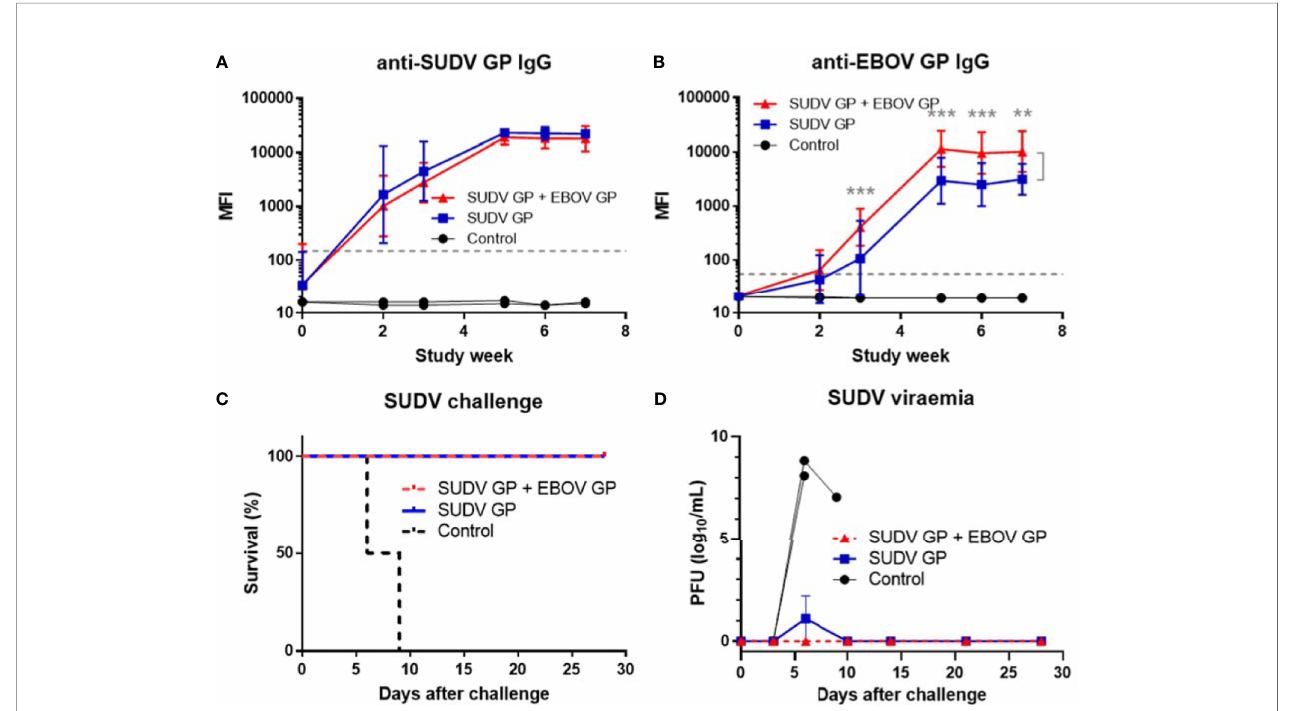
FIGURE 4 | Immune response after SUDV vaccination, survival and viremia after SUDV challenge. MIA performed in triplicate for animals vaccinated at three-week intervals with three doses of SUDV GP with adjuvant (n=4) or SUDV GP + EBOV GP with adjuvant (n=4). Controls received adjuvant only (n=2): (A) SUDV GP-binding IgG and (B) EBOV GP-binding IgG. Each data point for vaccinated groups represents geometric mean ± 95% con fi dence interval whereas data points for controls were plotted per individual animal. The dashed grey line marks the threshold for positive detection of antigen-speci fi c IgG at 3 SD above mean MFI of negative control samples. (C) Kaplan-Meier survival curves after challenge with SUDV. (D) SUDV viremia as assessed by plaque assay. Each data point for vaccinated groups represents mean ± SEM. Data points for controls were plotted per individual animal. **p < 0.01, ***p <